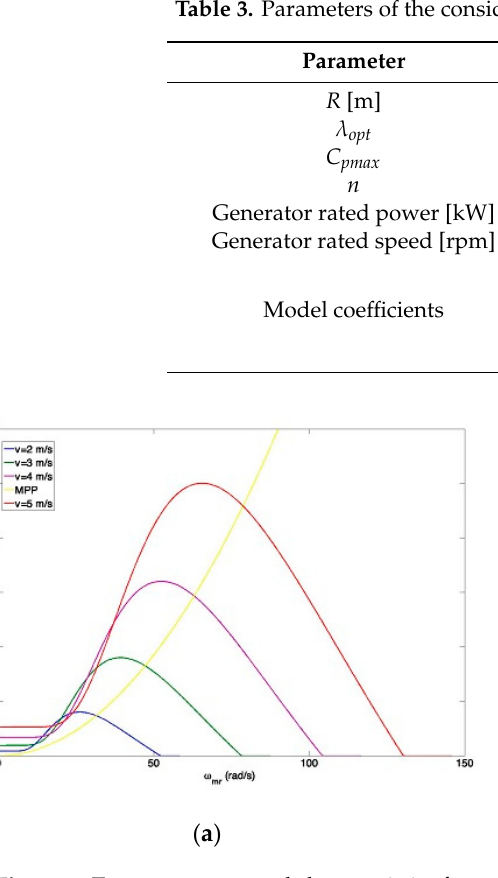
Figure 6. Torque versus speed characteristics for several wind speed values: ( a ) 5.5 kW horizontal axis wind turbine (HAWT) (locus of the MPPs in yellow); ( b ) 1 kW vertical axis wind turbine (VAWT).